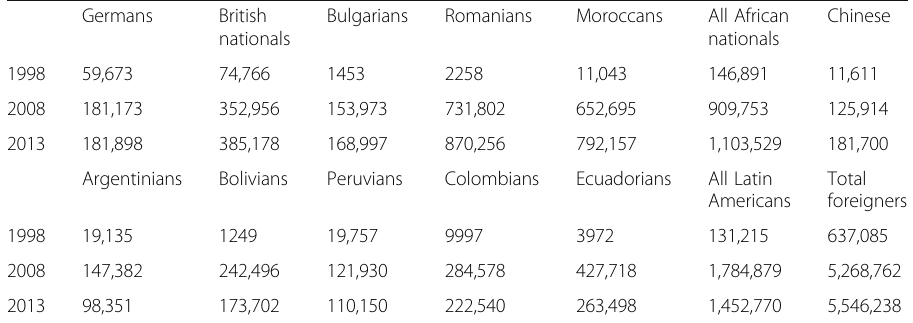
Table 1 Foreign population in Spain for selected nationalities (source: Continuous Register, INE) Germans British Bulgarians Romanians Moroccans All African Chinese nationals nationals 1998 59,673 74,766 1453 2258 11,043 146,891 11,611 2008 181,173 352,956 153,973 731,802 652,695 909,753 125,914 2013 181,898 385,178 168,997 870,256 792,157 1,103,529 181,700 Argentinians Bolivians Peruvians Colombians Ecuadorians All Latin Total Americans foreigners 1998 19,135 1249 19,757 9997 3972 131,215 637,085 2008 147,382 242,496 121,930 284,578 427,718 1,784,879 5,268,762 2013 98,351 173,702 110,150 222,540 263,498 1,452,770